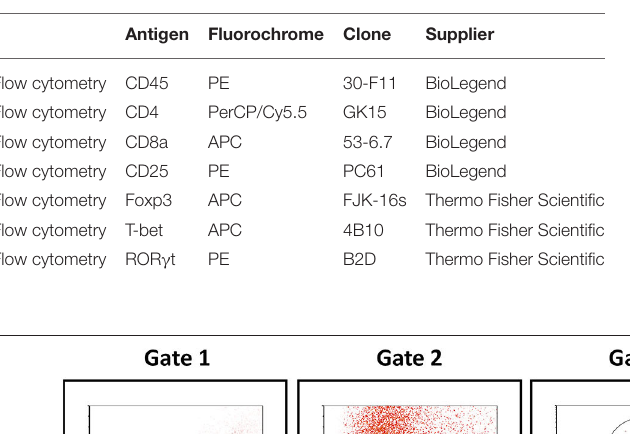
TABLE 1 | Overview of antibodies used in flow cytometry.